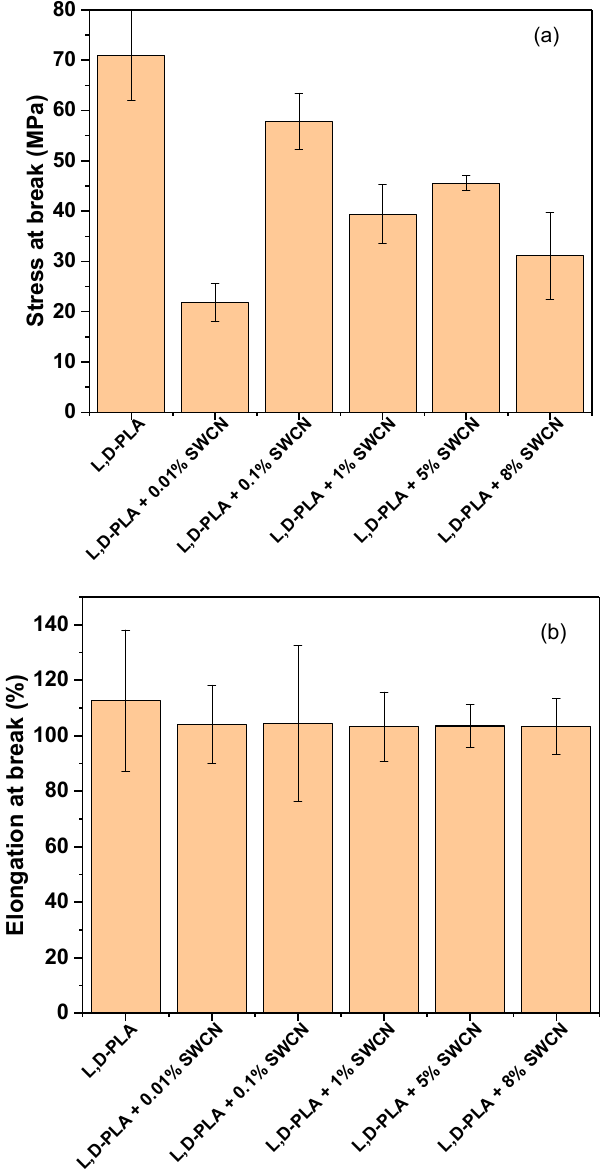
Figure 13. Stress at break ( a ) and elongation at break ( b ) of L , D -PLA with